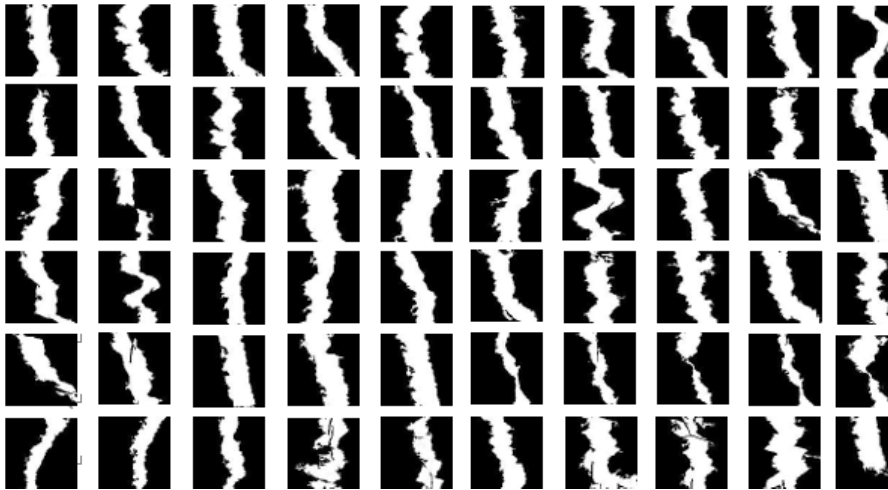
Figure 11. Dangerous gap sample image dataset.